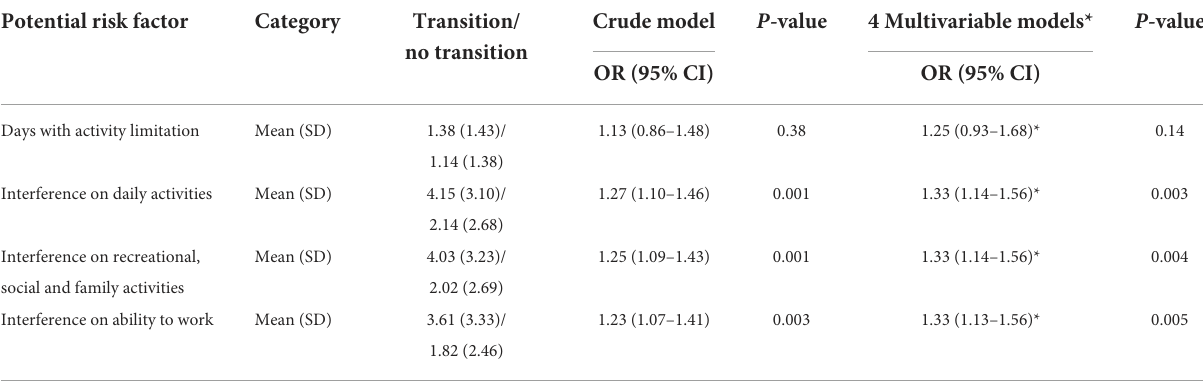
TABLE 4 Binary logistic regression analyses assessing the association between disability and the acute to chronic transition at 3 months of follow-up. Potential risk factor